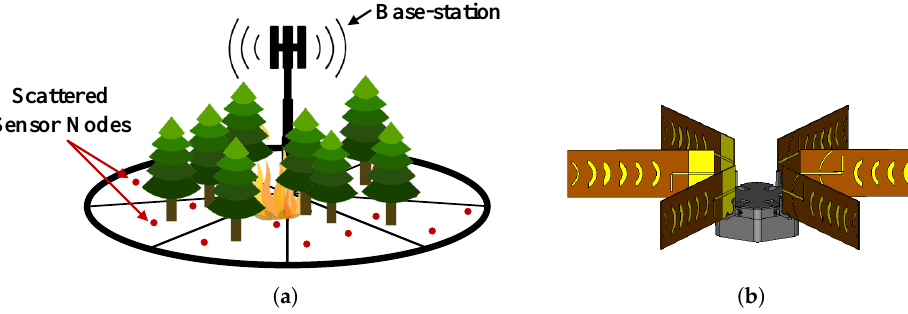
Figure 1. Multi-sector WSN: ( a ) Illustration of a possible configuration scenario and ( b ) proposed base station